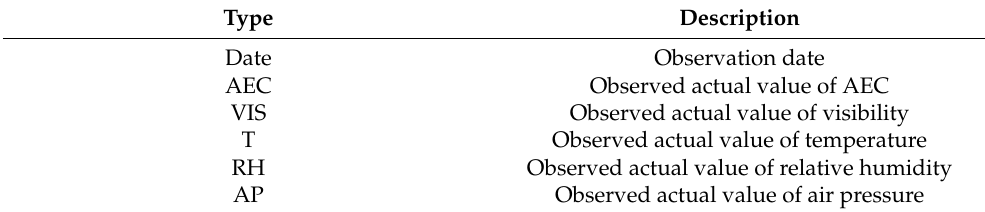
Table 1. APM Properties